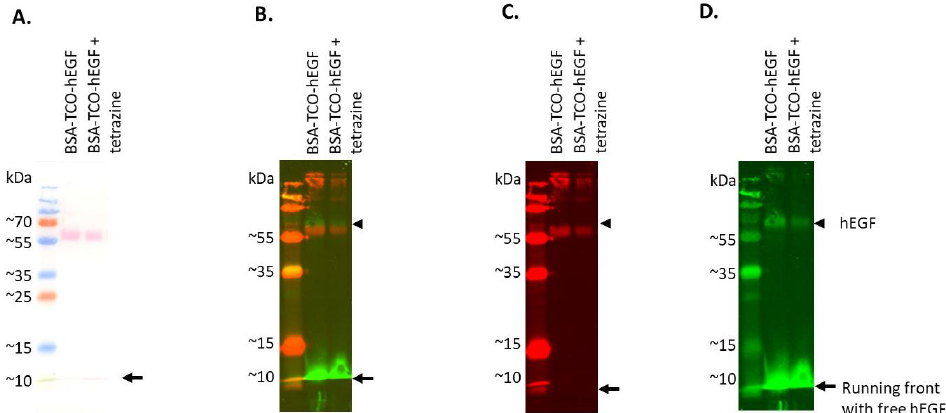
Figure 4. Western blot of samples containing BSA, hEGF–TCO, and tetrazine demonstrate successful hEGF–TCO–BSA coupling and partial hEGF release following tetrazine exposure. ( A ) Total protein load visualized by Ponceau S, ( B ) combined channels of BSA (red) and hEGF (green), ( C ) isolated BSA signal, and ( D ) isolated hEGF signal. Black arrow indicates the running front, the location where free hEGF runs; arrowhead indicates the position of hEGF above the BSA band.